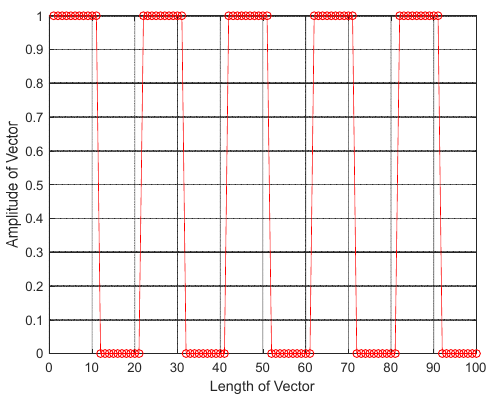
Figure 4. Estimated windowed vector.